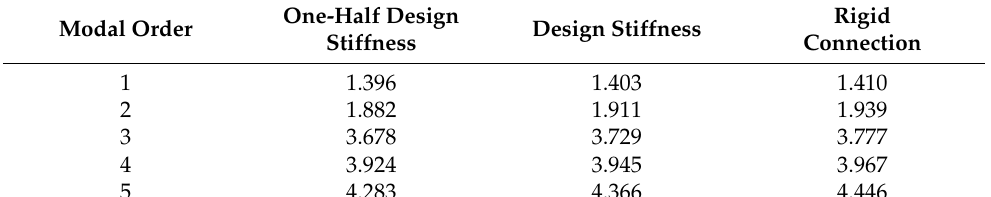
Table 10. Effect of shear-resistant connectors on the self-vibration frequencies of the original structure.